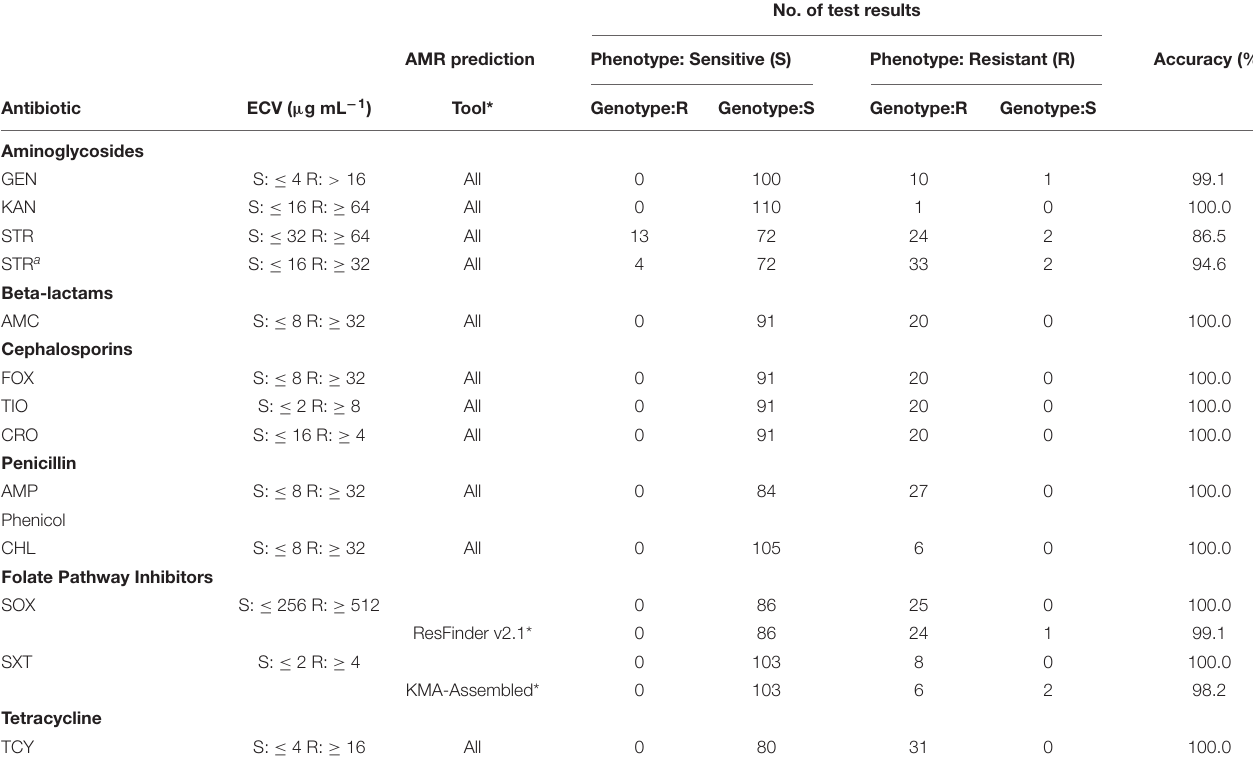
TABLE 6 | Accuracy of AMR phenotype predictions in Salmonella by AMR-gene prediction